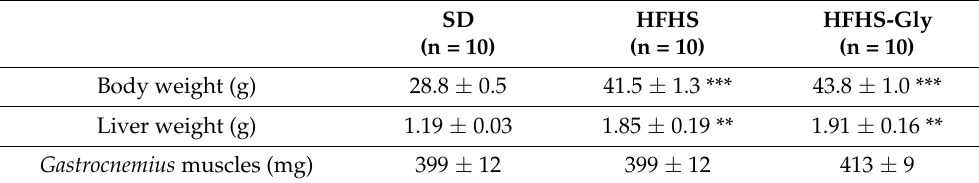
Table 1. Animal characteristics at sacrifice.